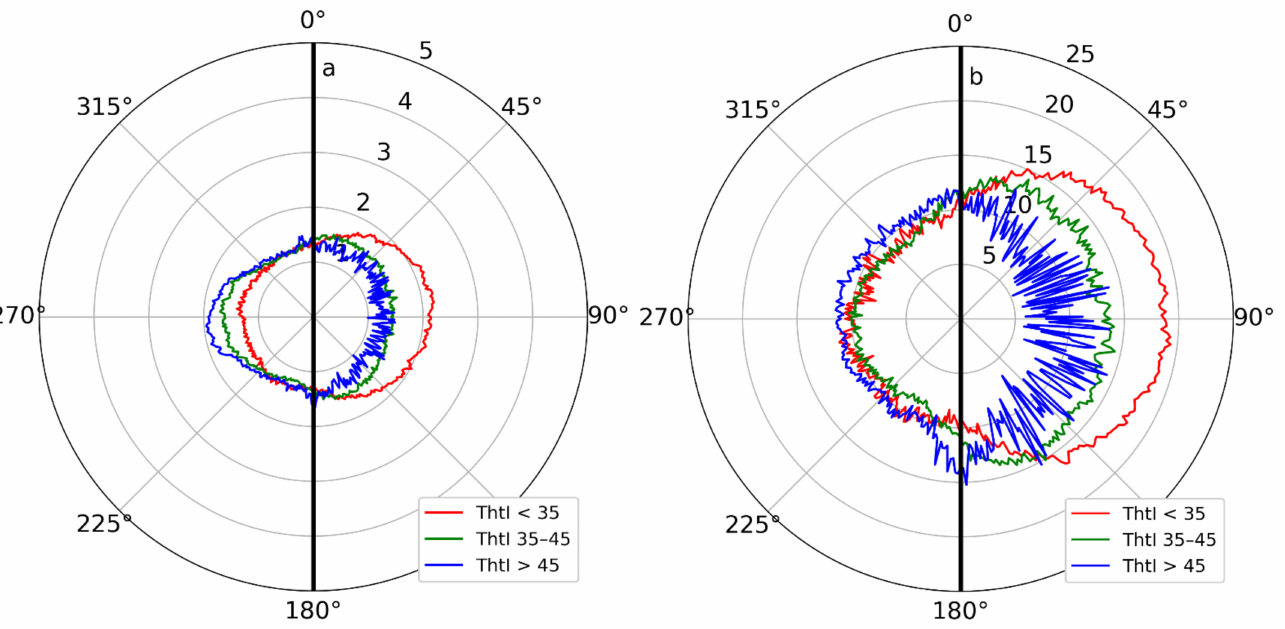
Figure 13. Standard deviation (m) of elevation ( a ) and slope ( b ) differences related to slope orientation angle for different local incidence angles (in